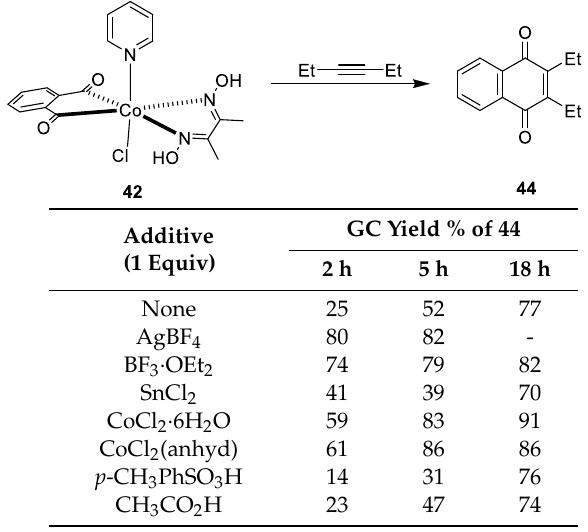
Table 5. Effects of Additives on 2,3-diethyl-1,4-naphthoquinone 44 formation at 80 °C [75].